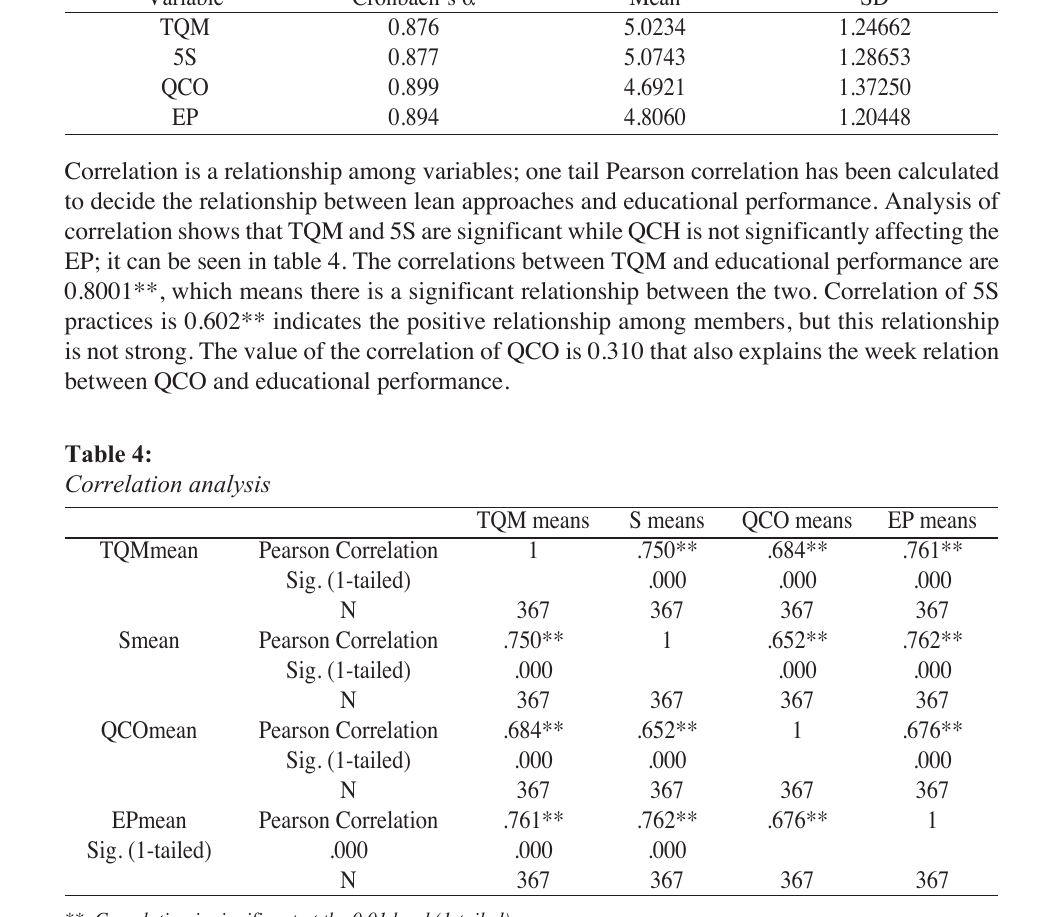
Table 3: Validity and Reliability Variable